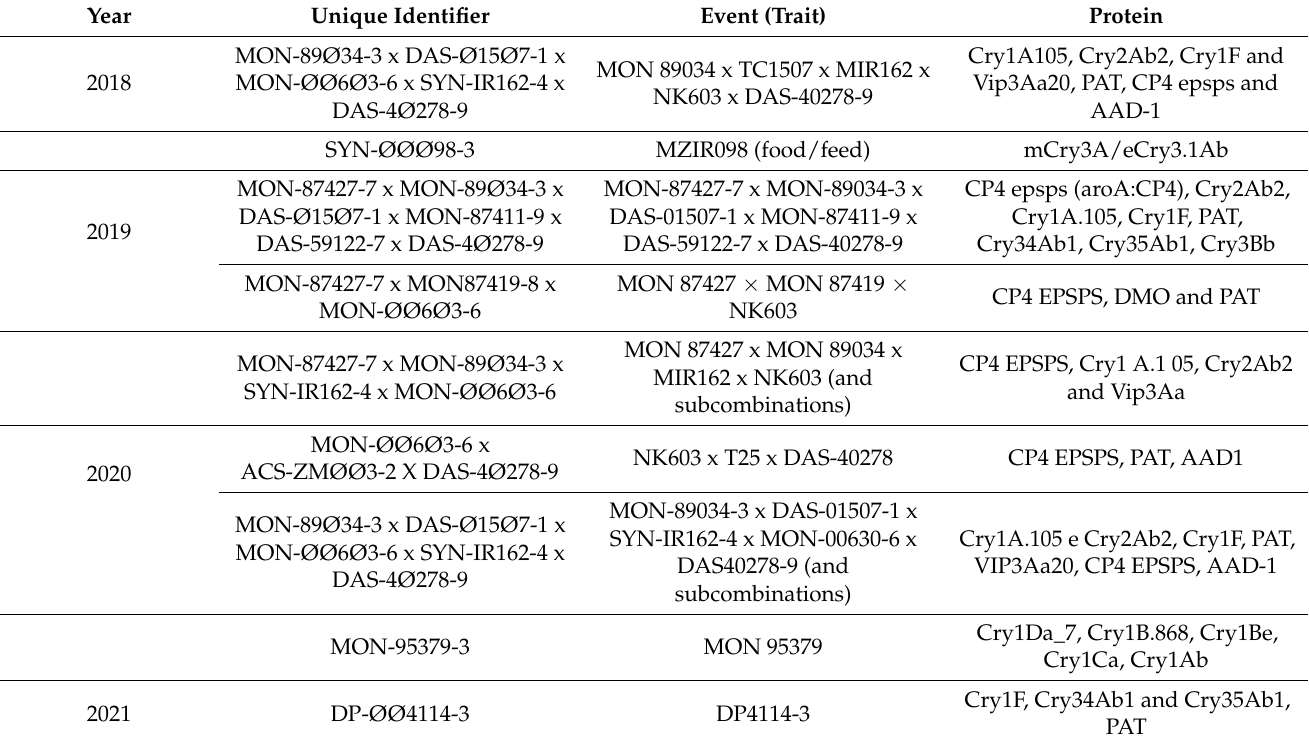
Table 4. GM maize commercial approvals in Brazil from 2018 to